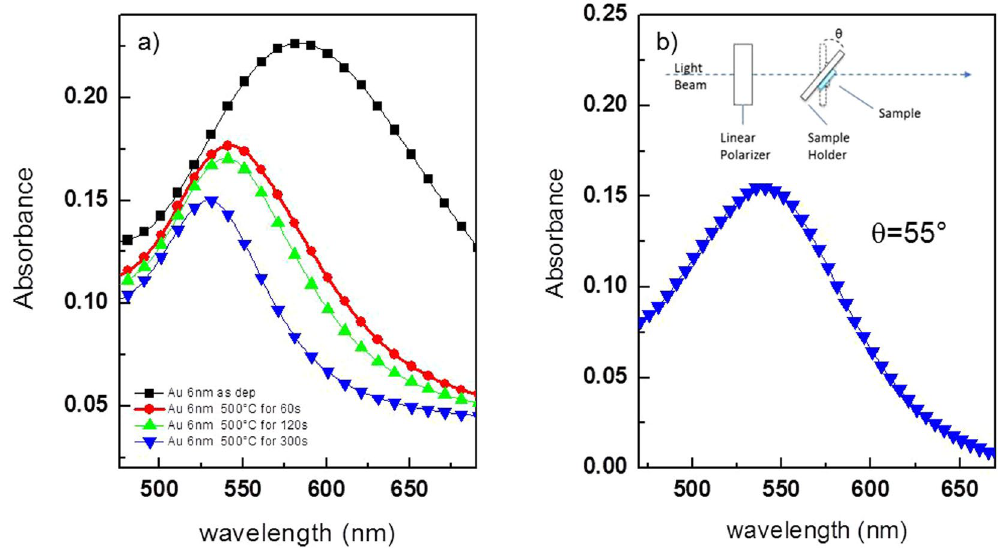
Figure 2. ( a ) Optical absorption spectra in the UV-VIS spectral range of a nanostructured Au samples before and after rapid thermal annealing treatments recorded at normal incidence. ( b ) Absorption spectrum of the sample annealed for 300 s recorded at the sample incidence angle chosen for the TMOKE characterization in Kretshmann configuration.